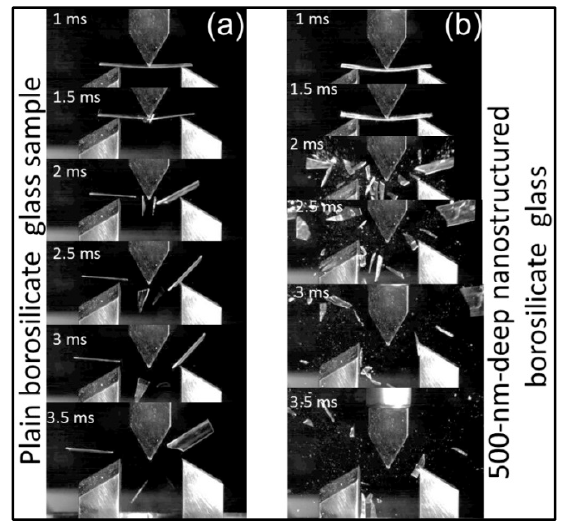
Figure 5. Dynamic fracture behavior captured by a high-speed camera for fragmentation analysis in 3PB test for borosilicate glass with dimensions of 60 mm × 20 mm × 0.7 mm: ( a ) plain borosilicate glass with two major fragments after fracture; ( b ) 500-nm-deep nanostructured borosilicate glass with multiple fragments after fracture.